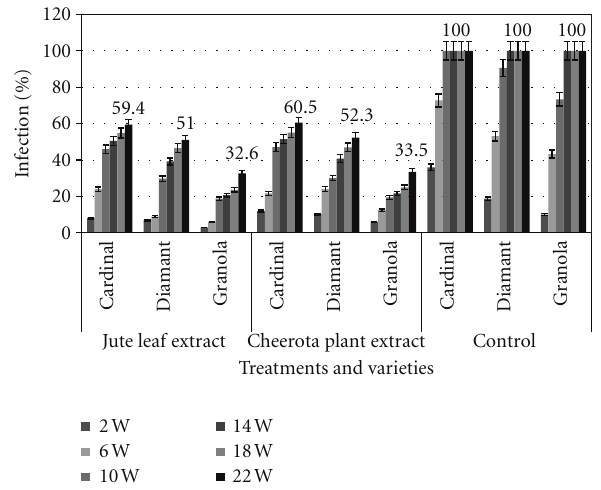
Figure 3: E ff ect of tuber treatment with jute leaf extract and cheerota plant extract on soft rot disease incidence of potato in storage.